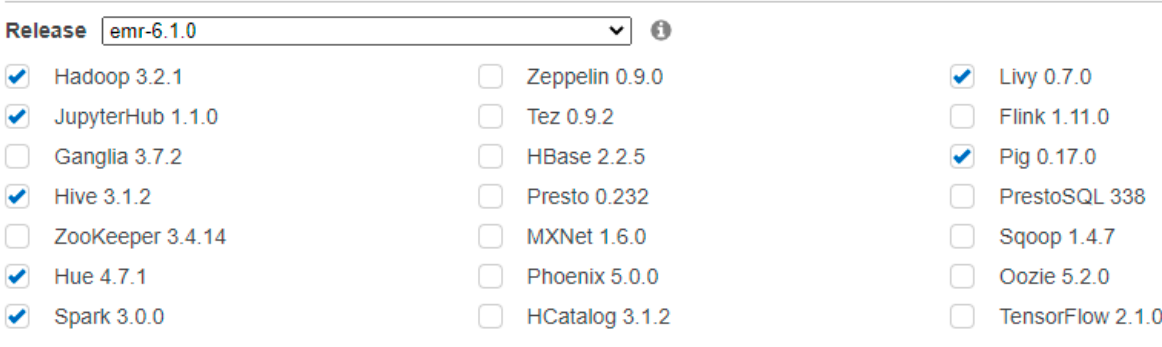
Figure 18. Amazon MapReduce configuration information.